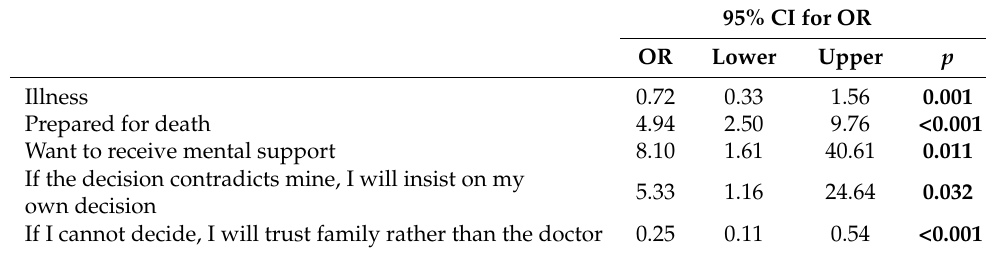
Table 4. Multivariable logistic